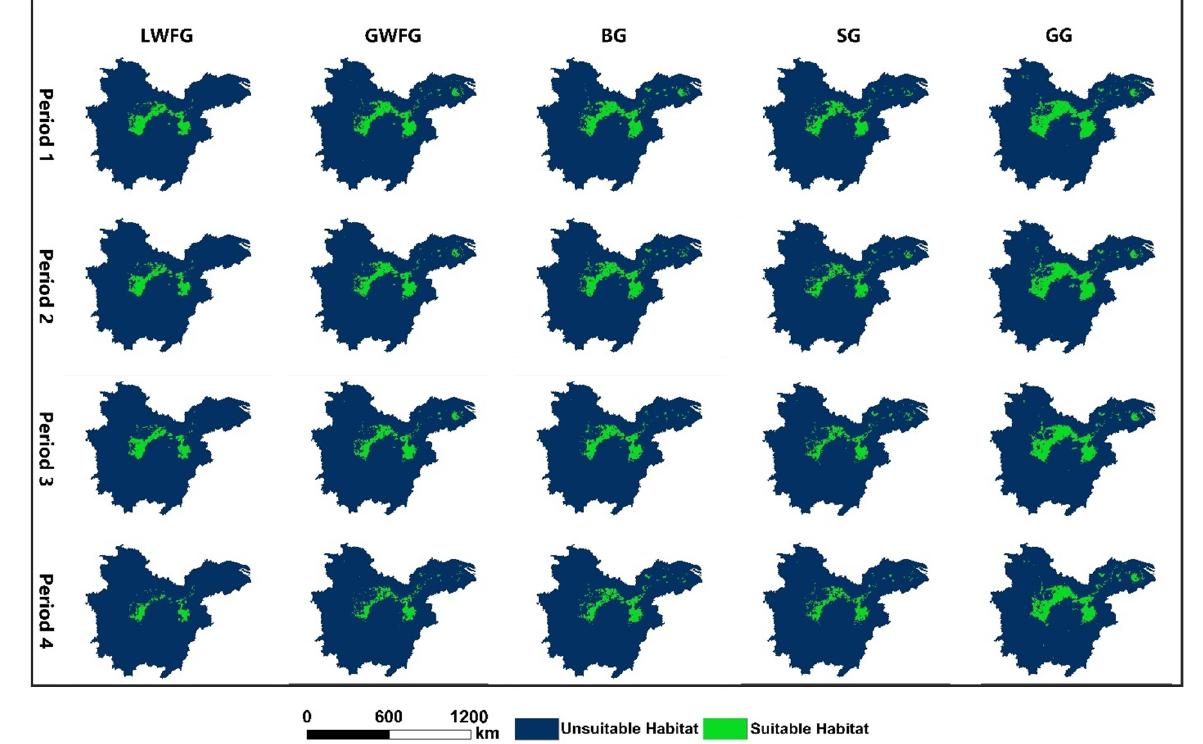
Figure 5. Suitable and unsuitable goose habitat areas in the MLYR for the four periods. Period 1 is 2000 − 2004, Period 2 is 2005 − 2009, Period 3 is 2010 − 2014, and Period 4 is 2015 − 2019. Lesser white- fronted goose (LWFG); greater white-fronted goose (GWFG); bean goose (BG); swan goose (SG); and greylag goose (GG). Table 3. The suitable habitat area (km 2 ) loss and the relative change ratio (%) of suitable habitat between two consecutive periods. Lesser white-fronted goose (LWFG); greater white-fronted goose (GWFG); bean goose (BG); swan goose (SG); and greylag goose (GG). Period 1 vs. Period 2 Period 2 vs. Period 3 Period 3 vs. Period 4